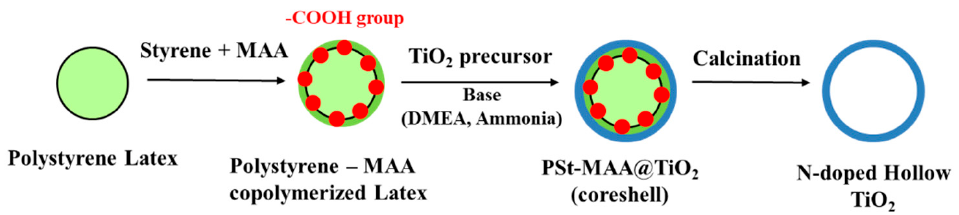
Figure 2. Schematic diagram of the synthesis of core@shell titania and N-doped hollow titania na- noparticles.